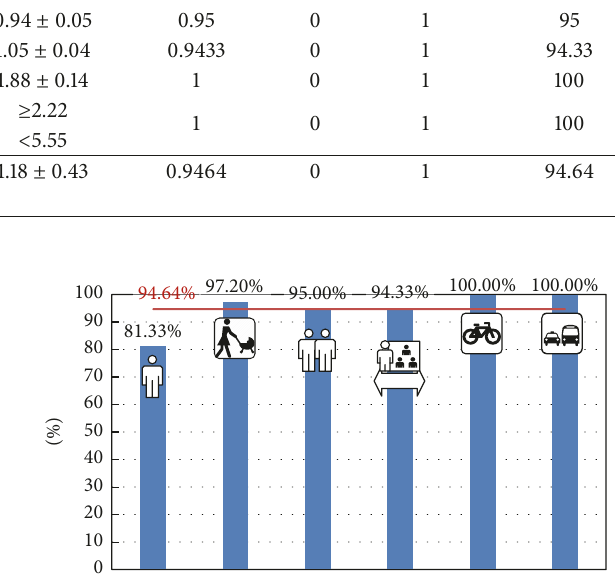
Figure 15: TPR of the classifier modelled by the fuzzy controller.